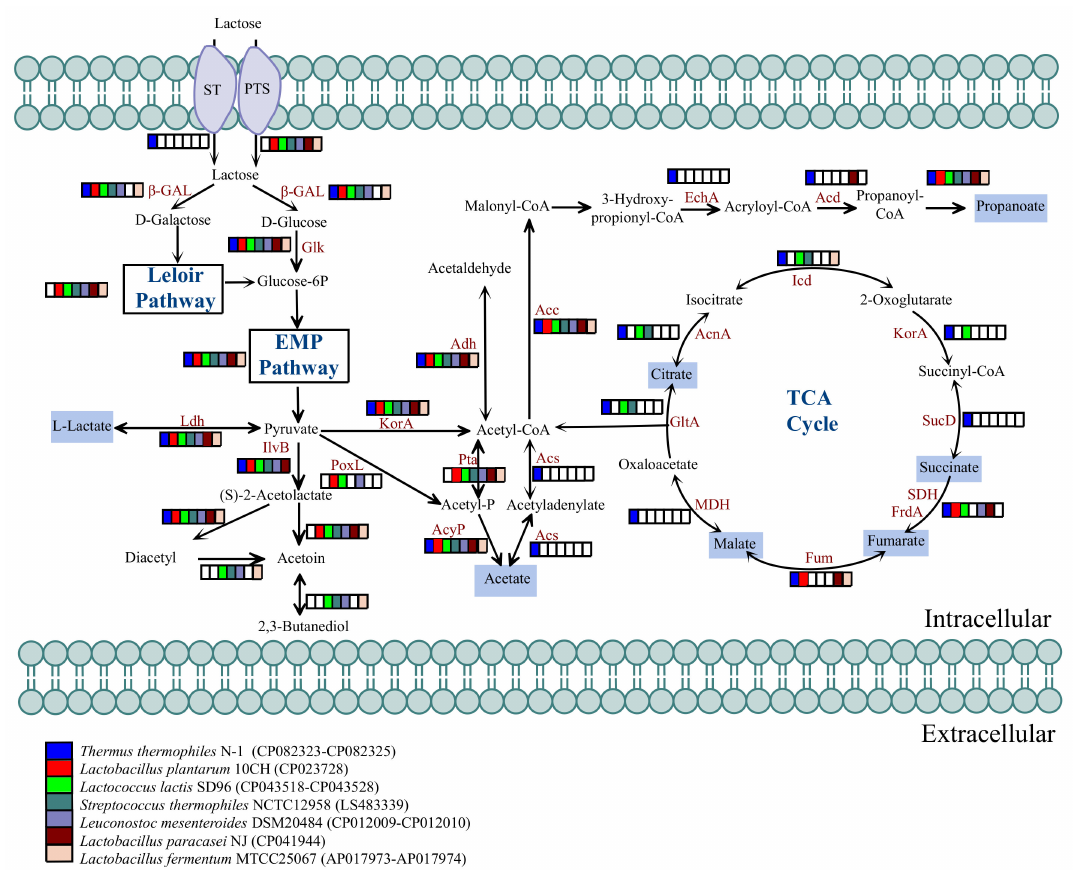
Figure 4. Predicted metabolic network of lactose metabolism and organic acid production in T. ther- mophilus